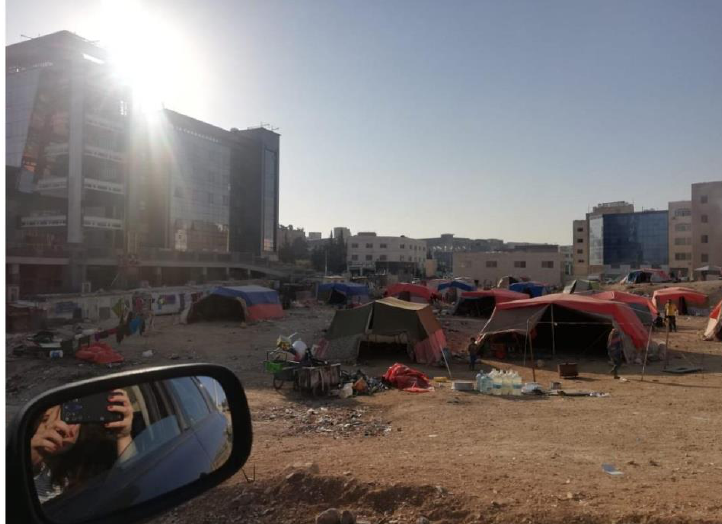
Figure 6. The picture was taken during the